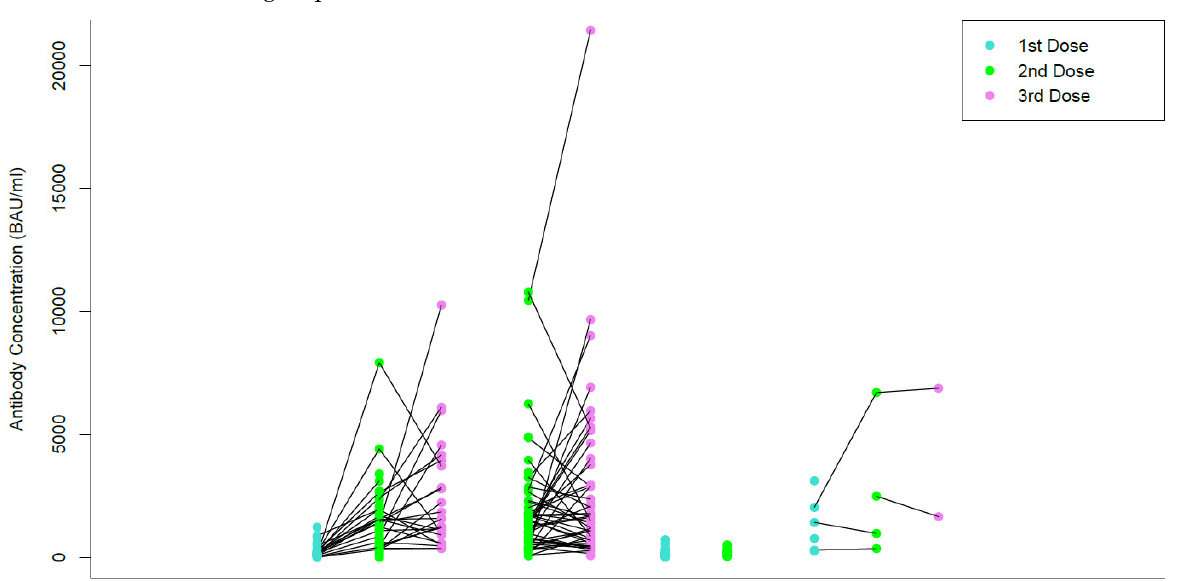
Figure 1. Antibody concentration after the first, second, and third